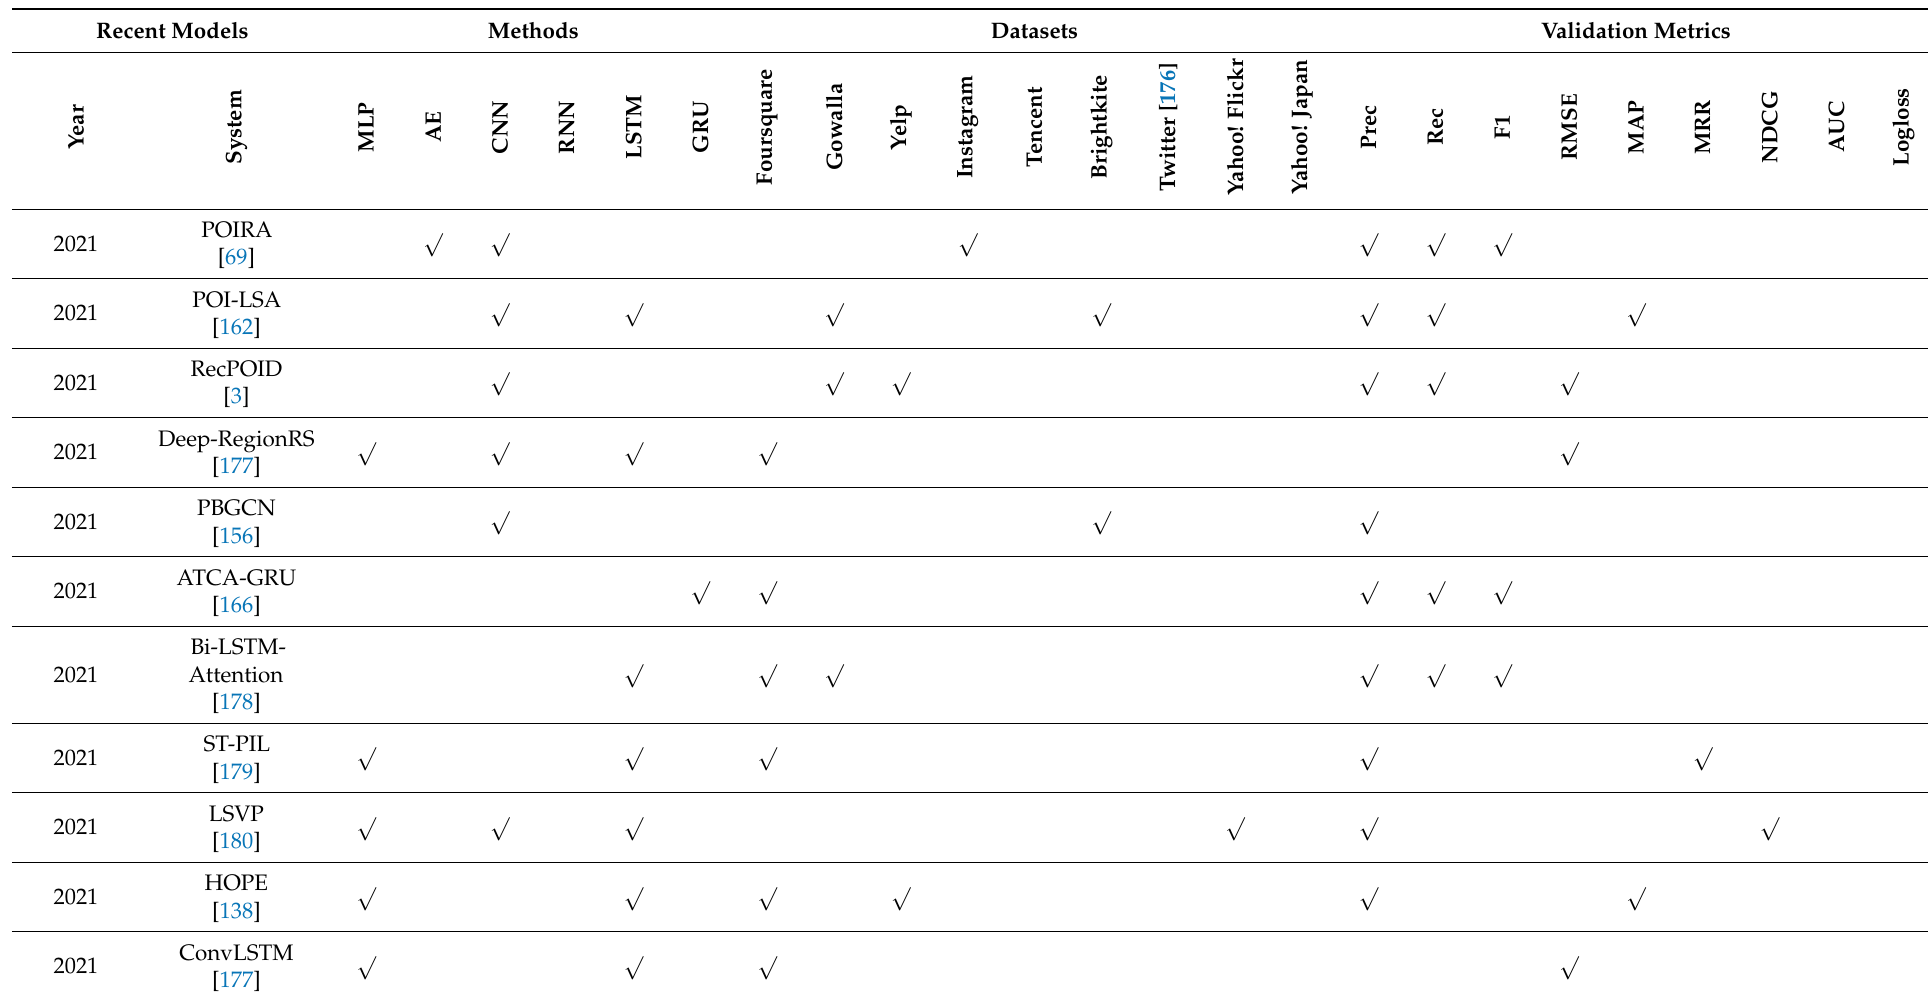
Table 1. Review of methods, datasets, and evaluation metrics of recent studies in the field of POI recommendation systems based on deep-learning